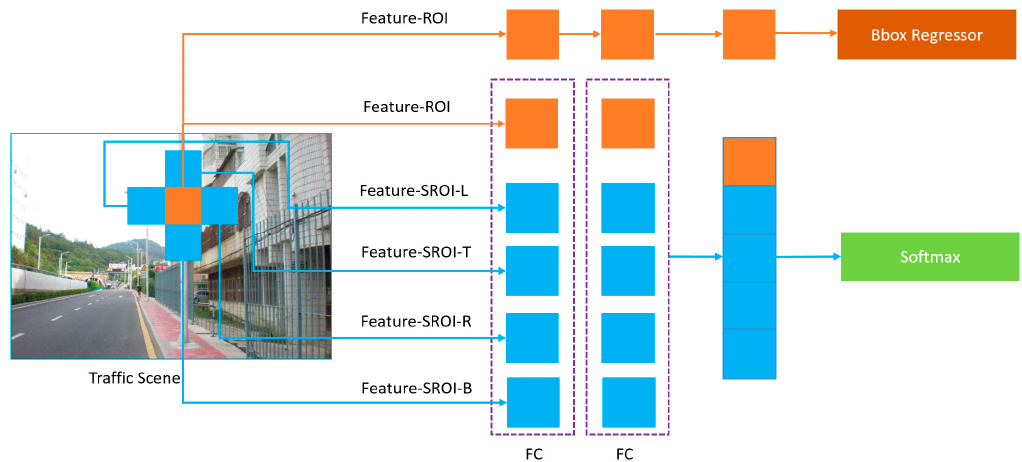
Figure 8. The feature combination of the region of interest (ROI) and secondary ROIs (SROIs). The L, T, R, B refers to the SR L , SR T , SR R , SR B , respectively.